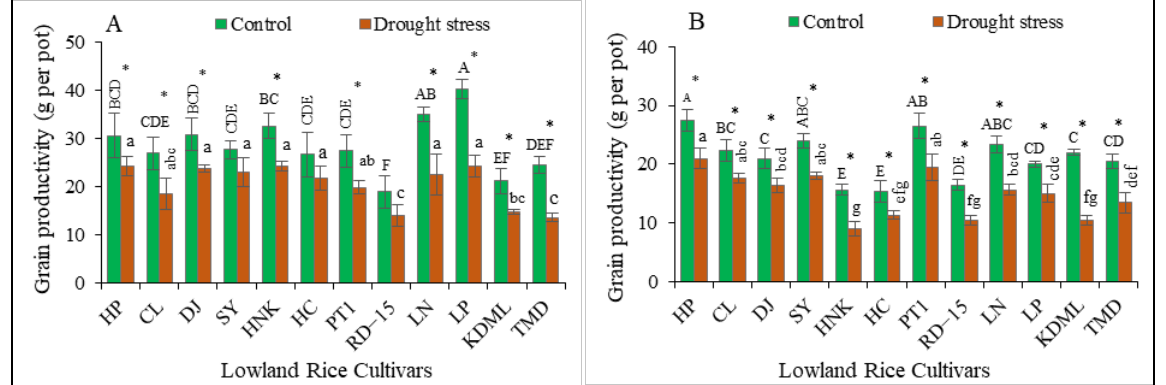
Figure 2. Grain productivity (grams per pot) of twelve lowland rice cultivars under control and drought stress treatments during first season ( A ) and second season ( B ). Means from three replications are presented with ± standard errors. Significance ( p < 0.05) among cultivars in control treatment is presented using capital letters, whereas significance ( p < 0.05) among cultivars in drought stress treatment is presented using lower-case letters. Significance among treatments for each cultivar is presented by stars (*). HP: Hom Pathum, CL: Chor Lung, DJ: Dum Ja, SY: Sang Yod, HNK: Hom Nang kaew, HC: Hom Chan, PT1: Pathum Thani−1, LN: Lep Nok, LP: Look Pla, KDML: Khao Dawk Mali−105, TMD: Tia Malay Dang .